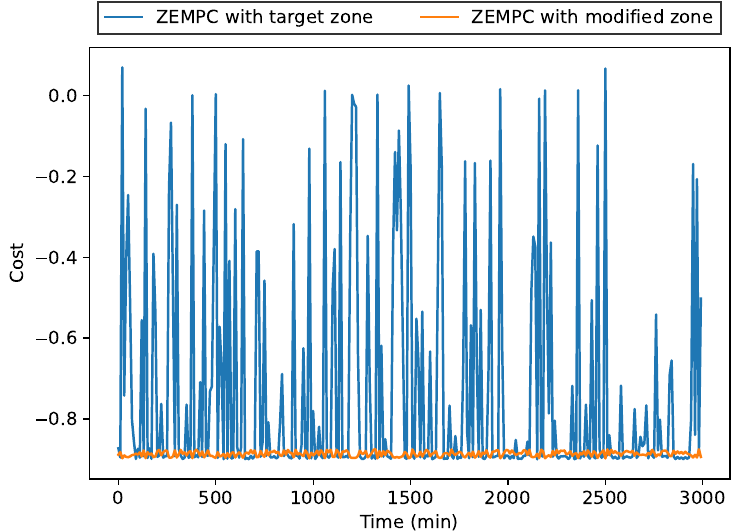
Figure 4. Trajectories of the stage cost for the absorption column under the operation of the zone EMPC control algorithm tracking the original target zone (blue) and modified zone